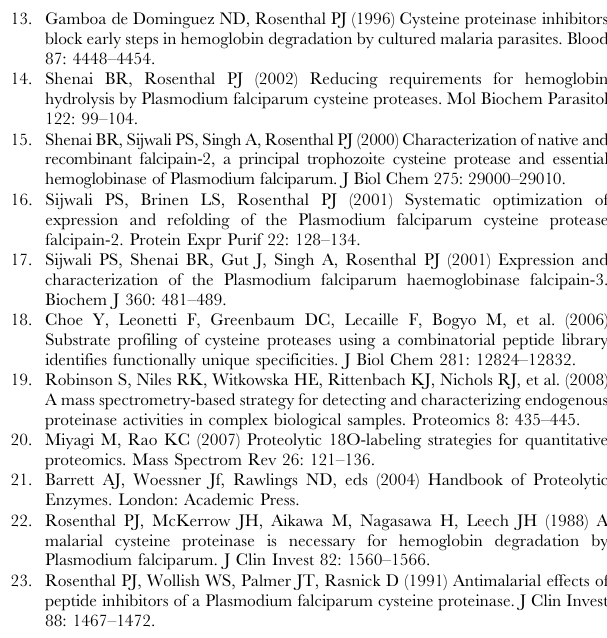
Figure S1 Graphical representation of amino acid preferences at P1–P4. P1–P4 amino acid preferences were plotted as a percentage of total cleavages, alongside percentage occurrence of each amino acid in the primary sequences of a and b globin. Table S1 This table shows (in two separate worksheets) sequences of the precursor peptide (for 12mer a and b globin peptides) and peptide products obtained as a result of falcipain mediated